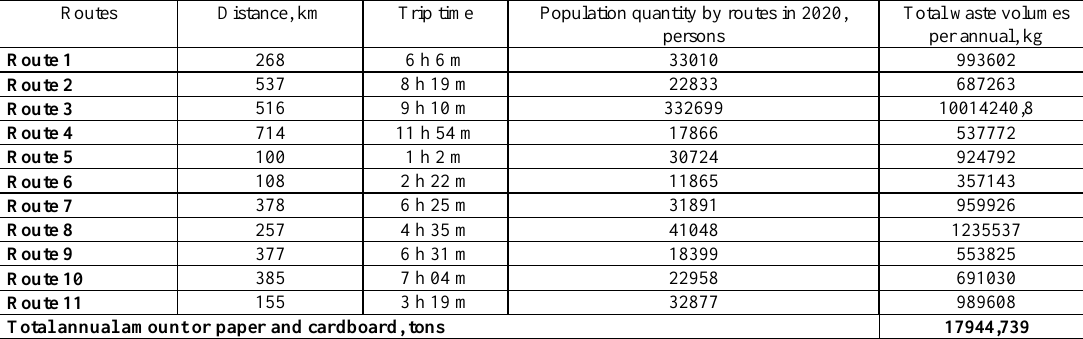
Table 1. Calculation of route parameters and needs for the number of trips.